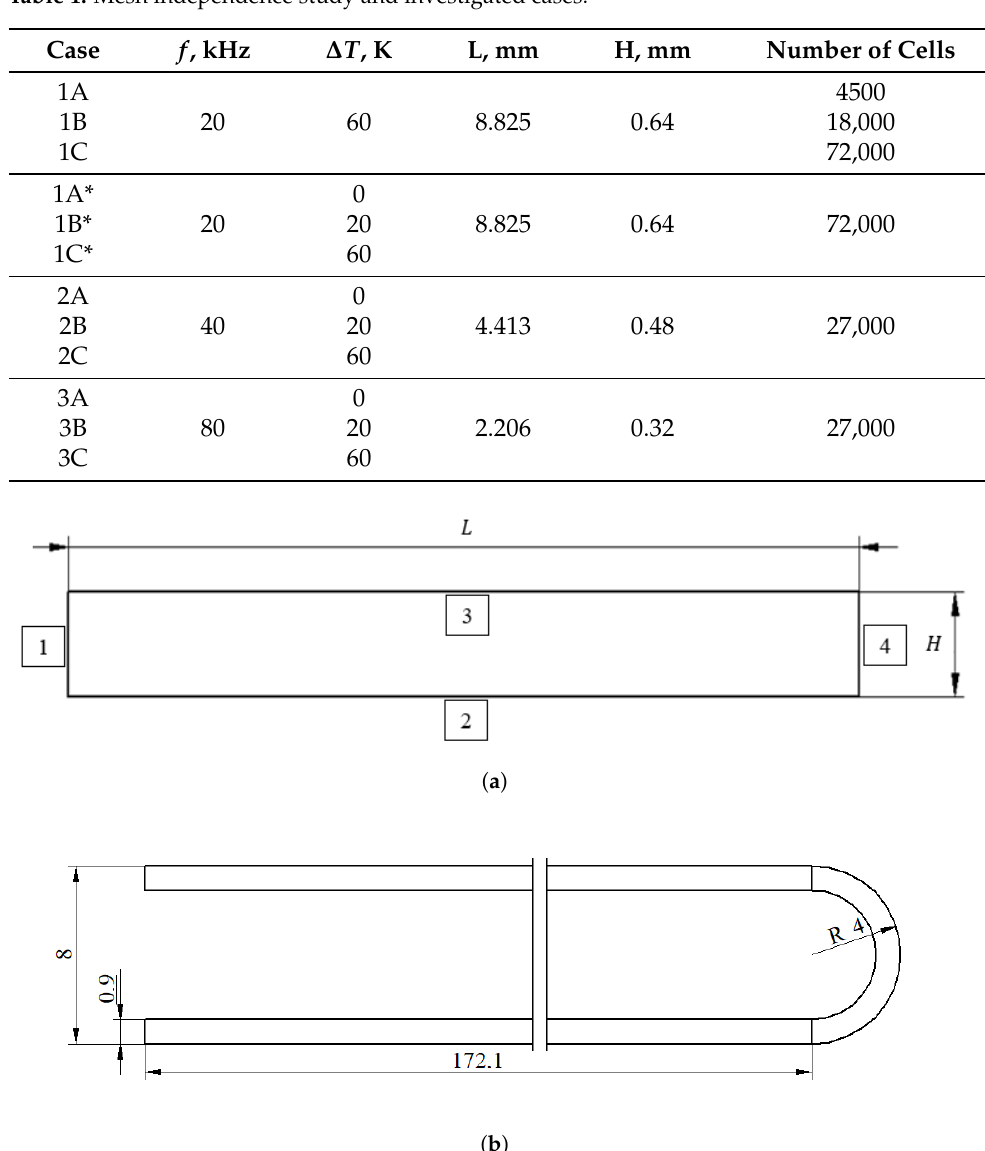
Figure 1. Investigated geometries. ( a ) Rectangular channel geometry. 1—moving left wall, 2—bottom wall, 3—top wall, 4—right wall, L —channel length, H —channel height. ( b ) Geometry of the Pt-100 thermometer filled with air, the dimensions are in mm. The 0.9 mm end walls are modelled as oscillatory boundary conditions with the frequency f = 20